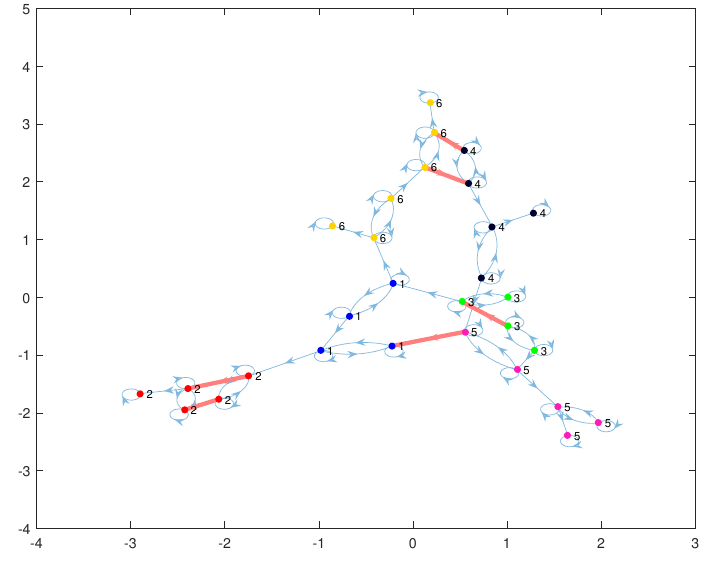
Figure 7. Communities of the DAE-based network representation of HEN 9sp-al1-MER were also identified. The colours of the nodes and their labels denote the community IDs. The highlighted edges are intercept Pinch.